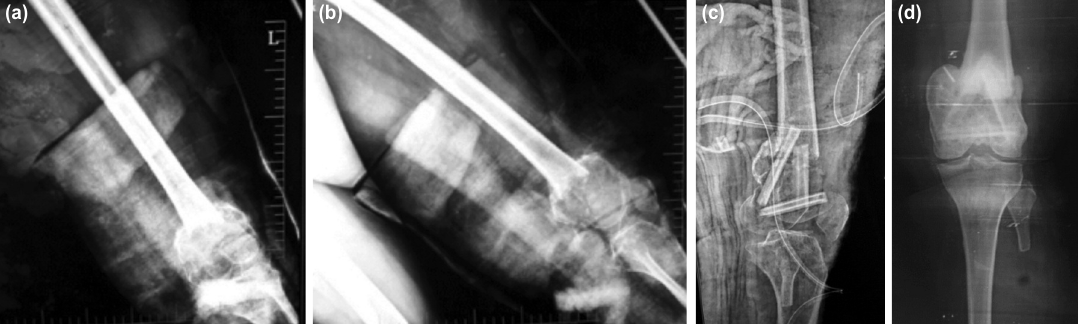
(a,b) Giant cell tumour of distal femur presenting with a pathological fracture. (c) Immediate post-operative radiograph. (d) Two 3: years post-operative